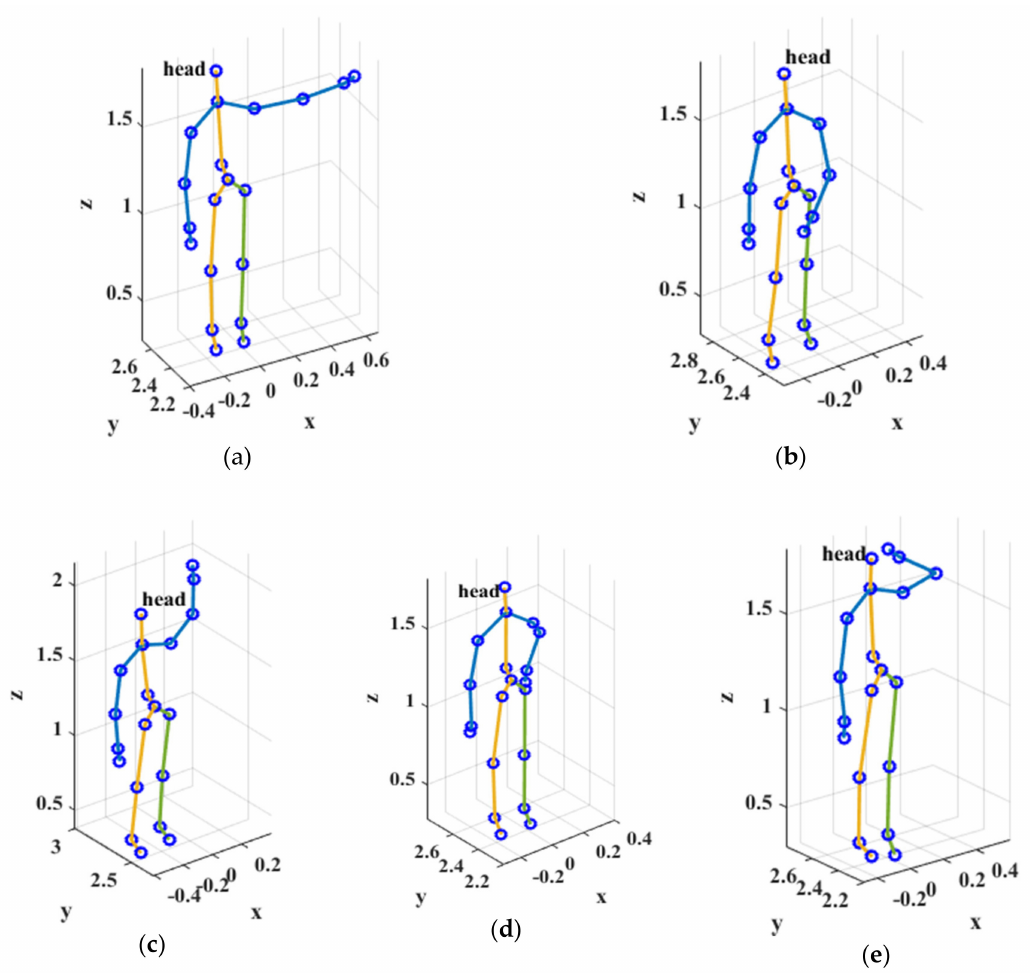
Figure 5. Five movements: ( a ) Shoulder abduction (90 ◦ ), ( b ) shoulder adduction, ( c ) shoulder flexion (0–180 ◦ ), ( d ) elbow flexion (hand to lumbar spine), ( e ) hand to